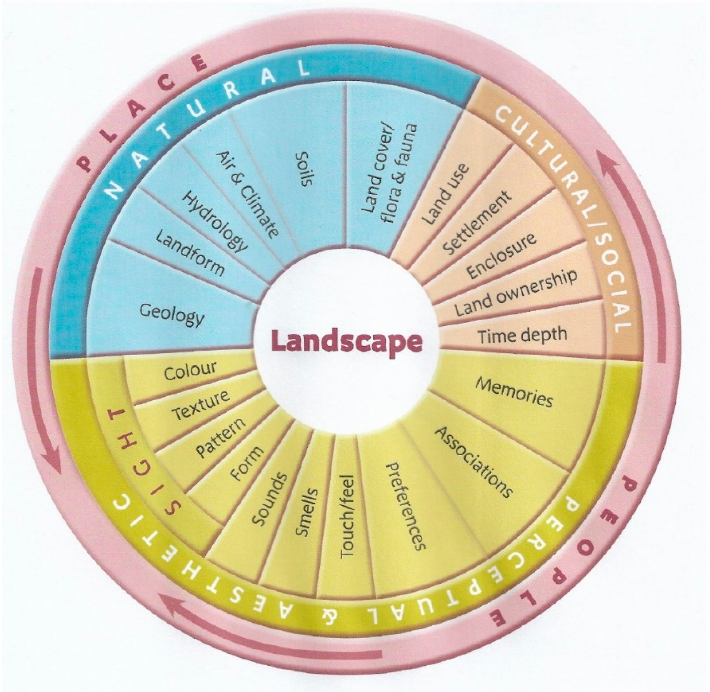
Figure 5. What is landscape? (Tudor, 2014, Reprinted with permission from Natural England, 2022).